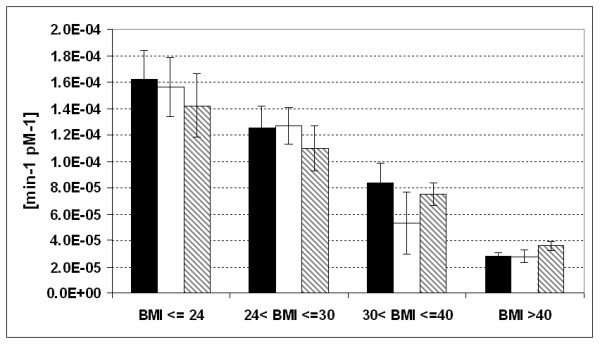
Mean values and standard errors for the Insulin Sensitivity Indices from the Single Delay Model (KxgI) and from the Minimal Model (SI). For the KxgI the average values were computed both in the Full Sample and in the reduced Sub-Sample. The average values of the SI index over the Full Sample were out of scale for all four groups and could not be plotted. Black bar = KxgI in the Full Sample, white bar = SI in the reduced Sub-Sample, striped bar = KxgI in the reduced Sub-Sample. Post-Hoc analysis by LSD test: for the KxgI in the Full Sample the significant comparisons were 1 vs 3 (P = 0.001), 1 vs 4 (P < 0.001), 2 vs 4 (0.001) and 3 vs 4 (P = 0.047); for the KxgI in the reduced Sub-Sample the significant comparisons were: 1 vs 3 (P = 0.001), 1 vs 4 (p < 0.001), 2 vs 3 (P = 0.008), 2 vs 4 (P = 0.002); for the SI in the reduced Sub-Sample the significant comparisons were: 1 vs 3 (P = 0.019), 1 vs 4 (P = 0.001), 2 vs 4 (P = 0.016).